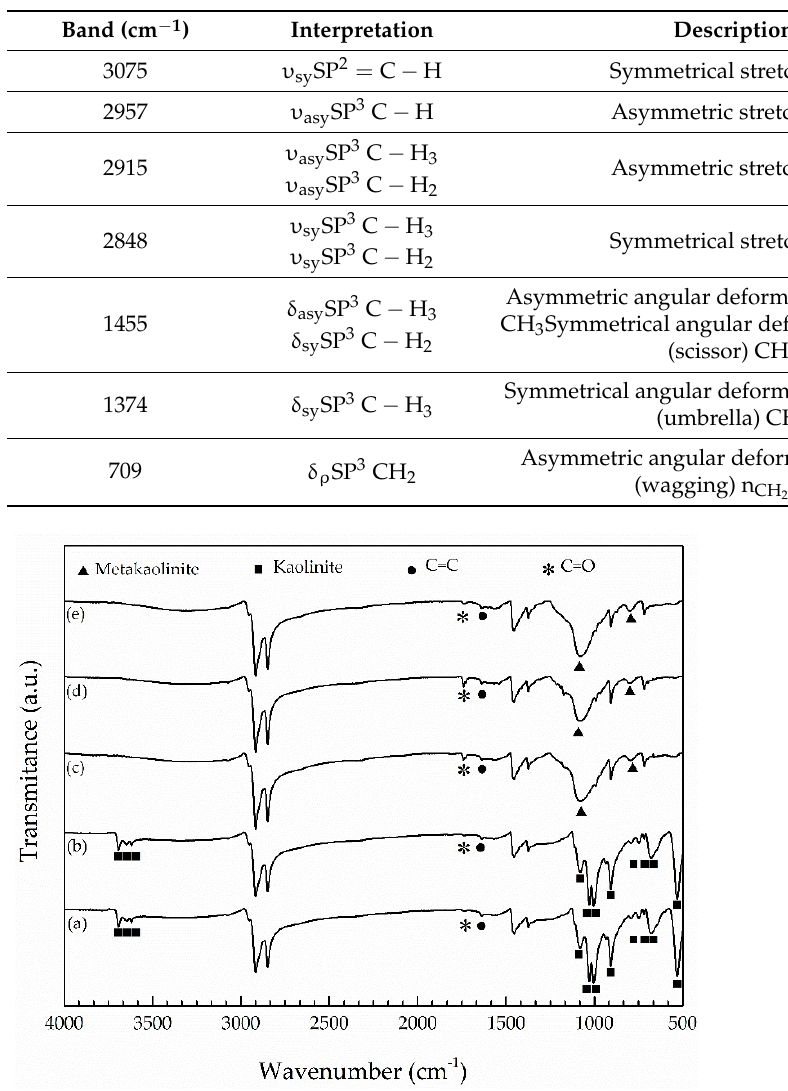
Figure 2. FTIR spectra of jacket layer of cables ( a ) A; ( b ) B; ( c ) C; ( d ) D and ( e ) E. ■ stands for kaolinite, ● stands for C=C and * stands for C=O bands, ▲ stands for